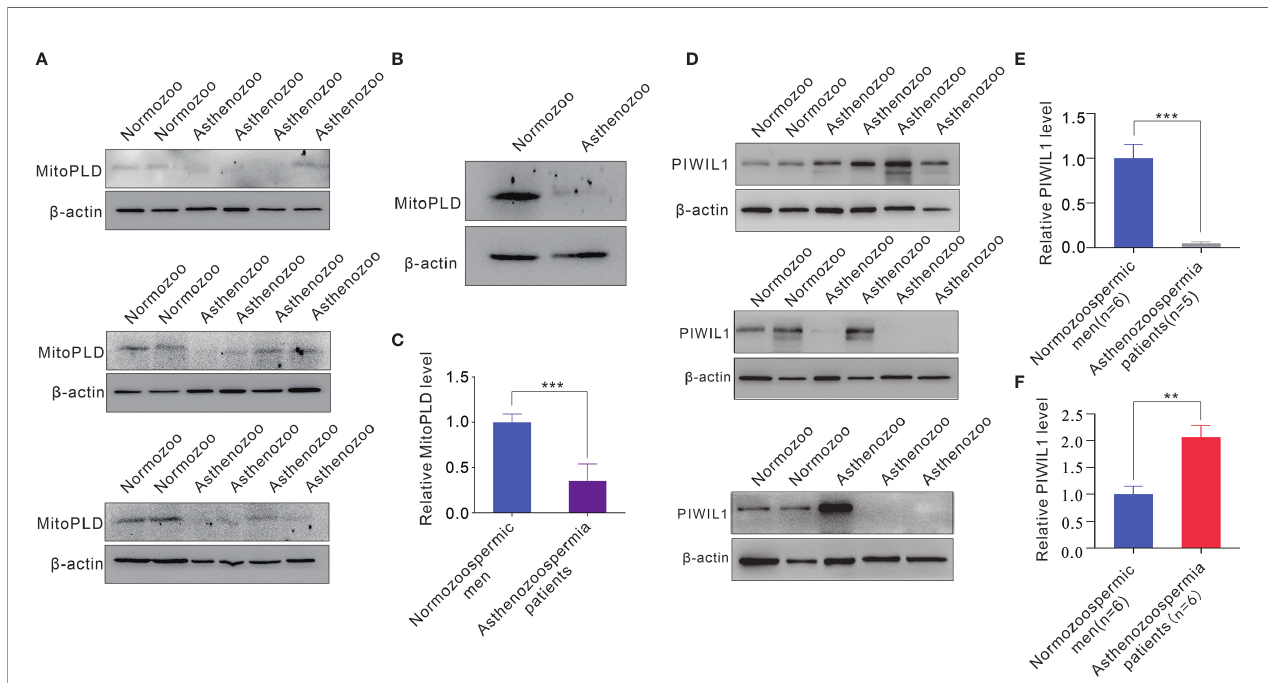
FIGURE 5 | The expression level of MitoPLD and PIWIL1 protein from sperms between asthenozoospermia patients and normozoospermic men. (A) Western blotting analysis of the expression levels of MitoPLD in individual sperm samples between asthenozoospermia patients and normozoospermic men. (B) Western blotting analysis of the expression levels of MitoPLD in pooled sperm samples between asthenozoospermia patients and normozoospermic men (each pooled from 10 individuals). (C) Quantitative analysis of panel (A, B) . (D) Western blotting analysis of the expression levels of PIWIL1 in individual sperm samples between asthenozoospermia patients and normozoospermic men. (E, F) Quantitative analysis of expression levels of PIWIL1 were decreased (E) or increased (F) in sperms of asthenozoospermia patients. **p < 0.01; ***p <